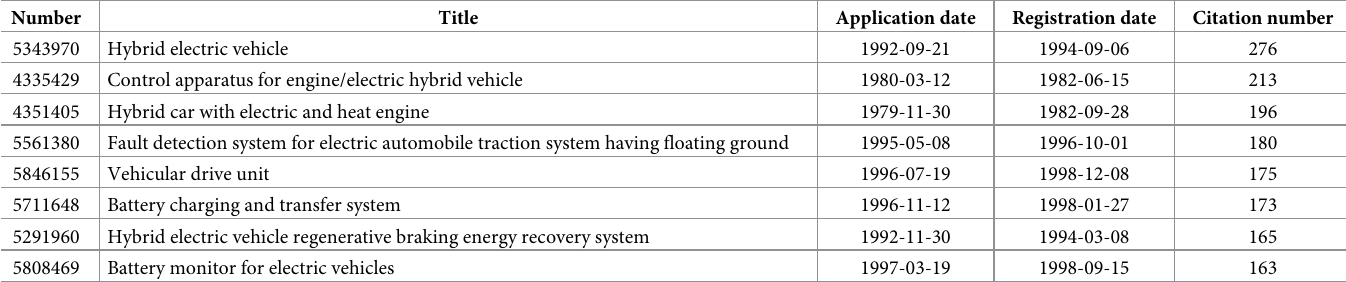
Table 1. Eight patents related to hybrid car technology.